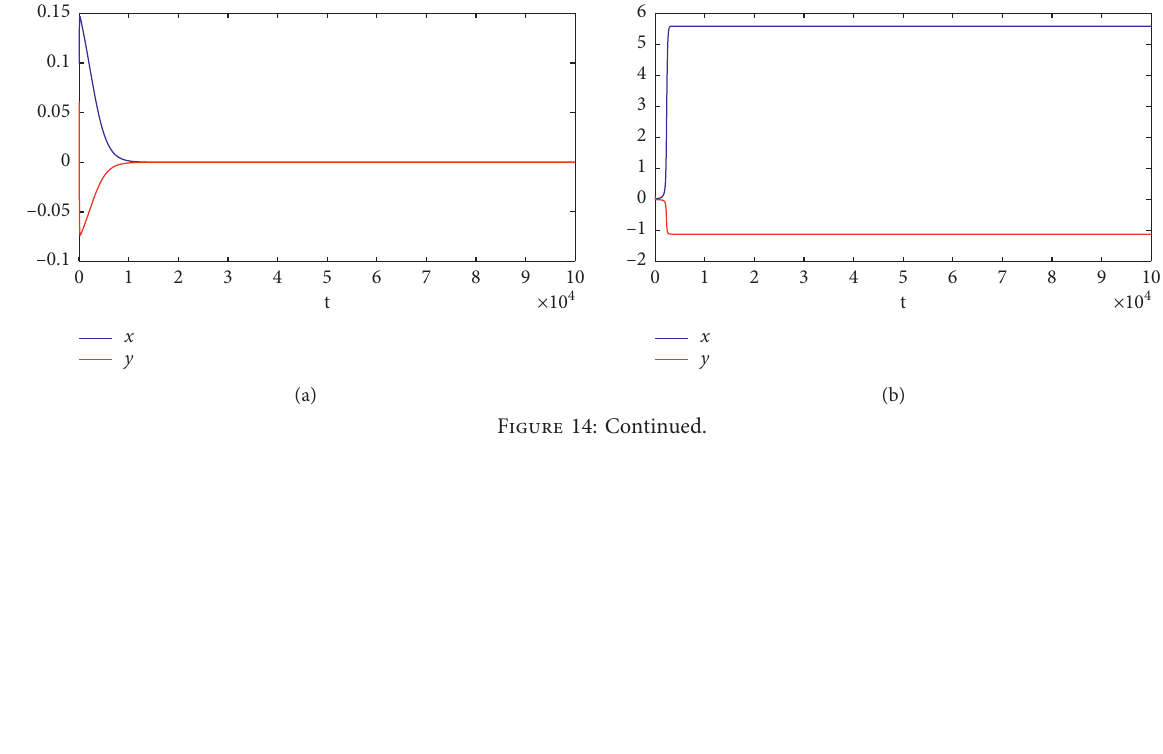
The pattern formation of the system when p � 0 . 8. The system is stable when